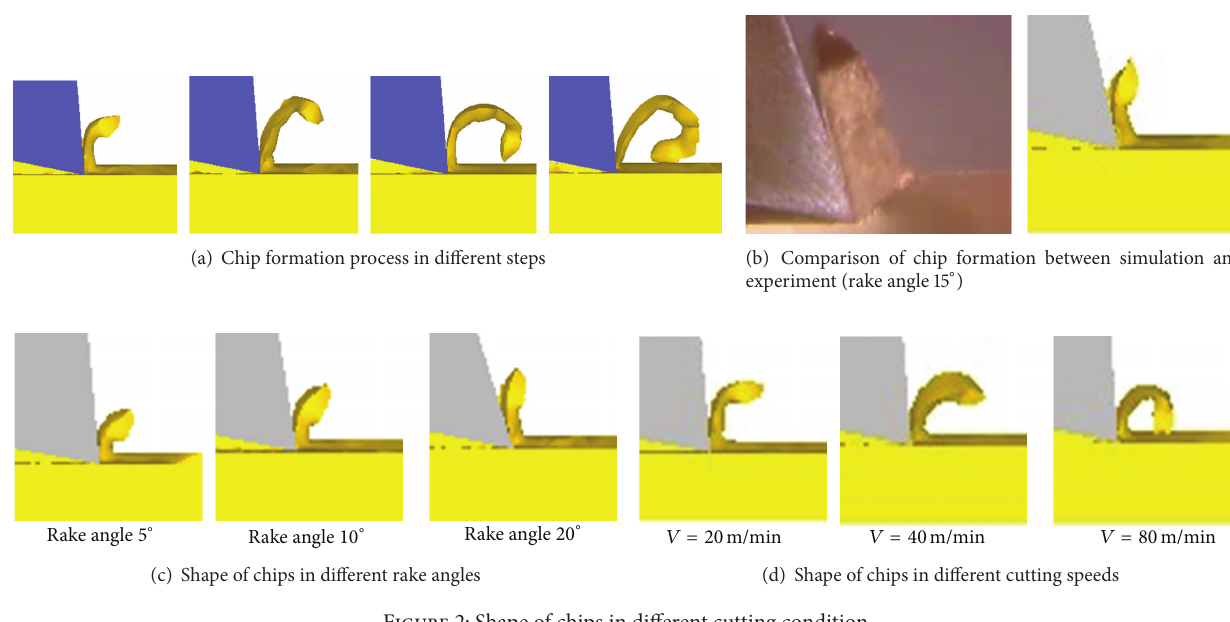
Figure 2: Shape of chips in different cutting